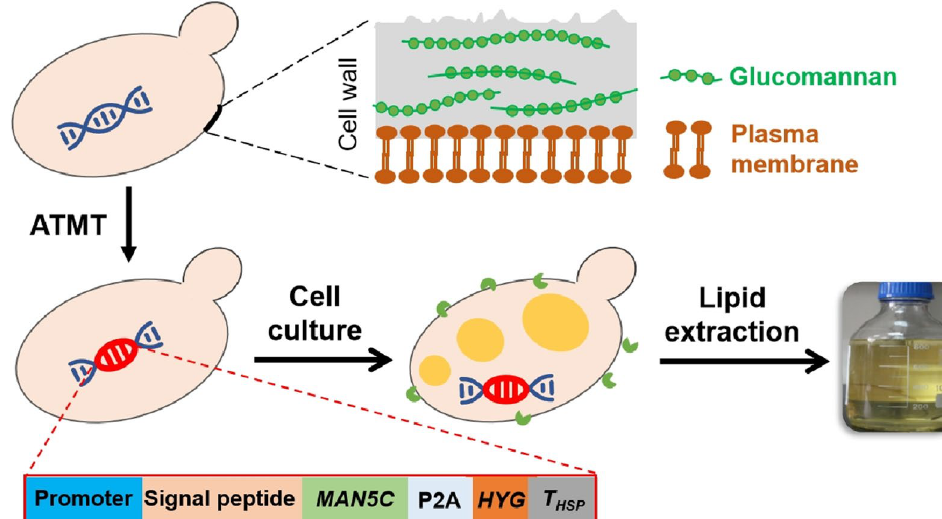
Fig. 1 Diagram of the strategy for expression of the cell wall lytic enzyme MAN5C in R. toruloides for improved lipid